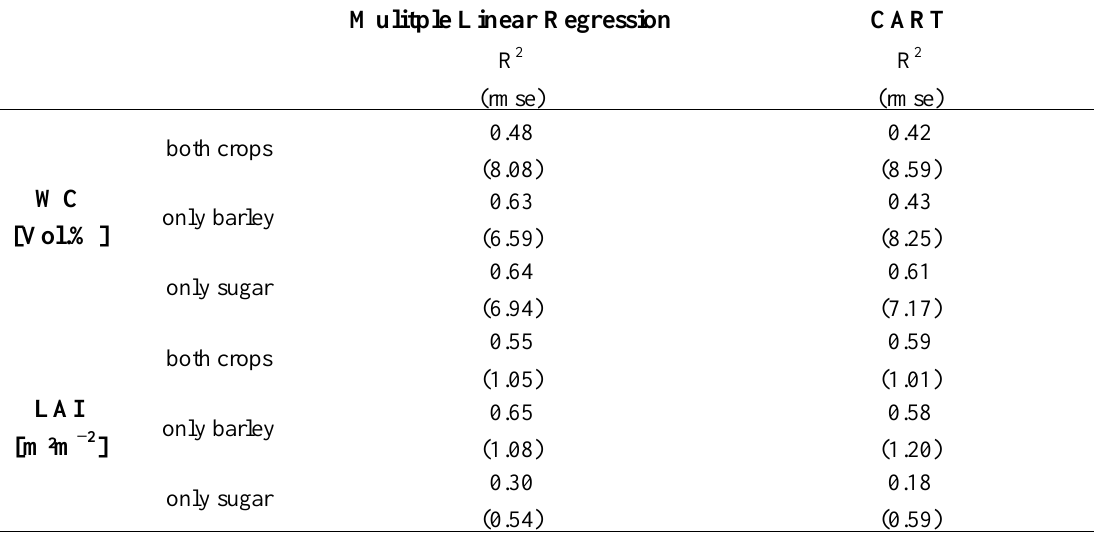
Table 5. Coefficients of determination (R 2 ) and root mean square errors ( rmse) for multiple linear regression and CART between LAI and WC using the best combinations of pre-selected SI’s from the analysis in Section 3.3 within a cross-validation (leave-one-out) framework. Results are representing cross-validation results for both crops (Spring Barley and Sugar Beet) together and separately for each